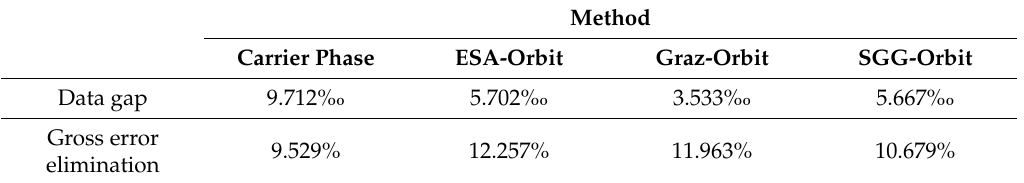
Table 3. Orbit data gap ratio and gross error elimination ratio of the residual accelerations of 71